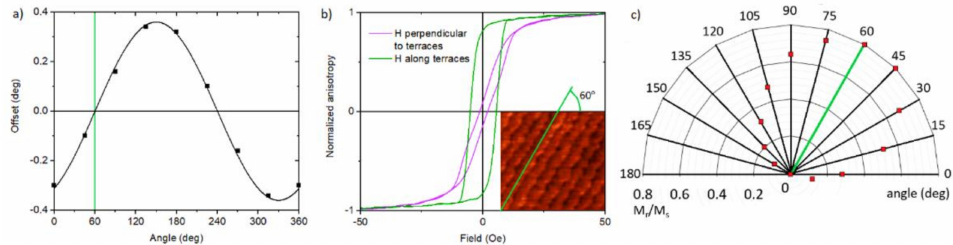
Figure 3. The measurements of the LSMO / STO sample prepared with the “bu ff er” method showing the correlation between ( a ) the STO (002) o ff set values as a function of the di ff erent directions in the sample plane ( b ) the magnetic hysteresis loop measured along the easy (green) and hard (pink) axes. In the inlet the AFM measurement of the sample surface, ( c ) the proportion of remanence to the magnetic saturation for di ff erent angles between the external magnetic field H and the [100] direction.